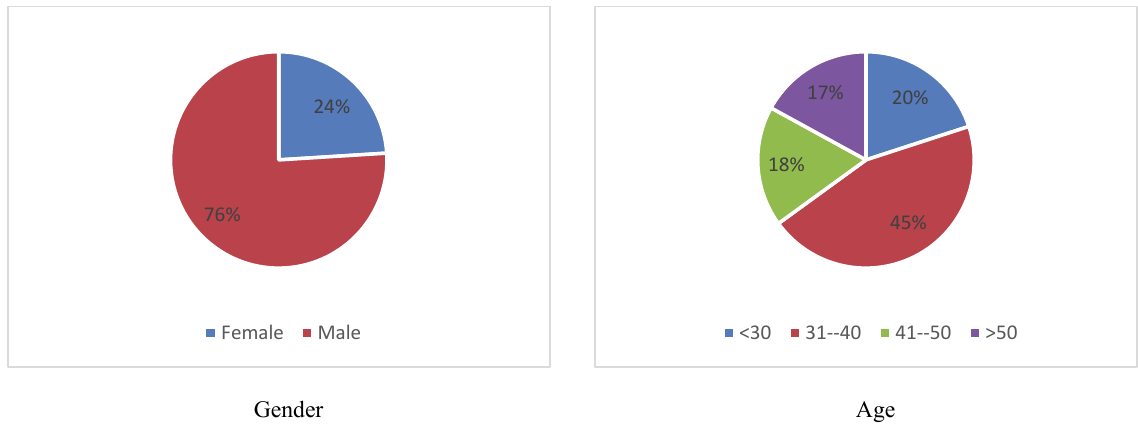
Fig. 1. Personal characteristics of the